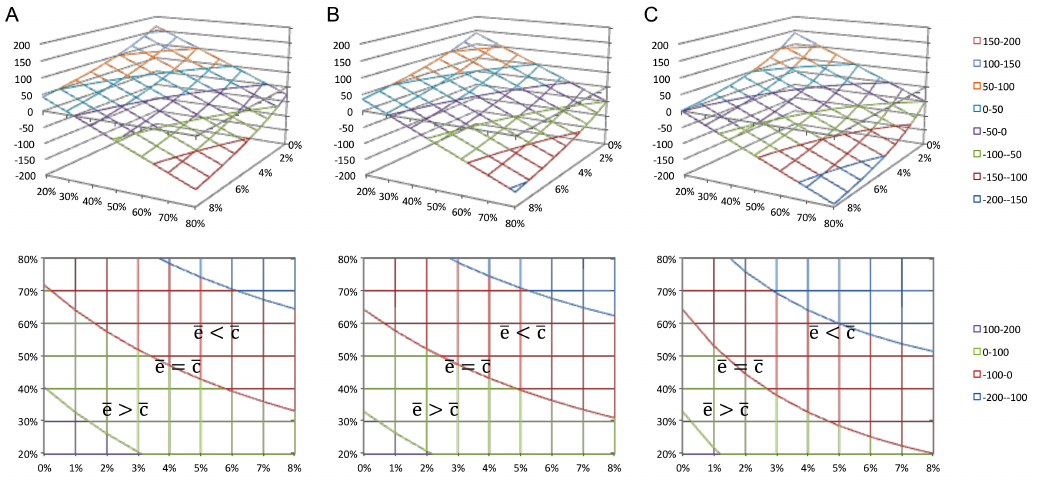
Figure 14. Trade-off between social discount rate (SDR) and risk level for three discounting approaches: ( A ) Decreasing by steps discounting; ( B ) Decreasing discounting; ( C ) Constant discounting (legend: